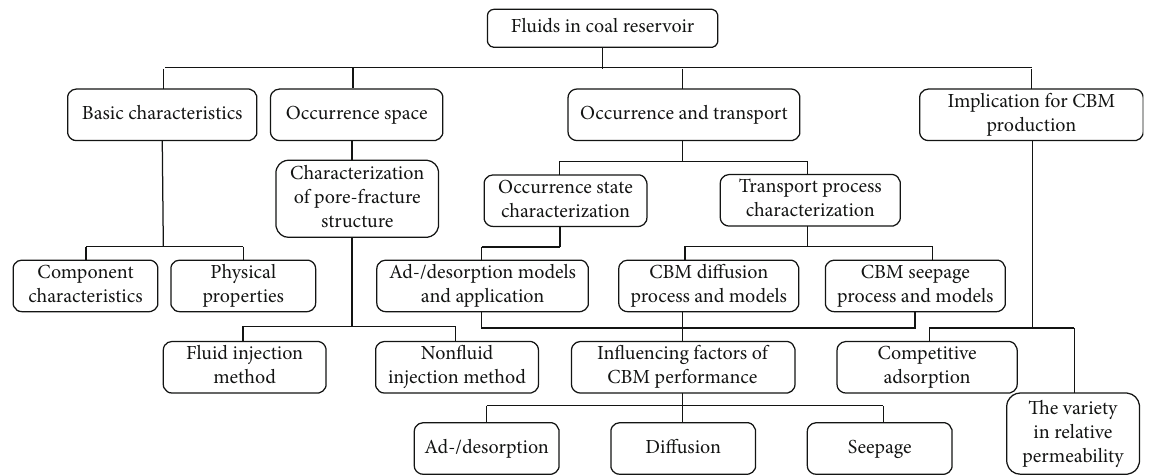
Figure 2: The general sketch of fl uid performance in coal